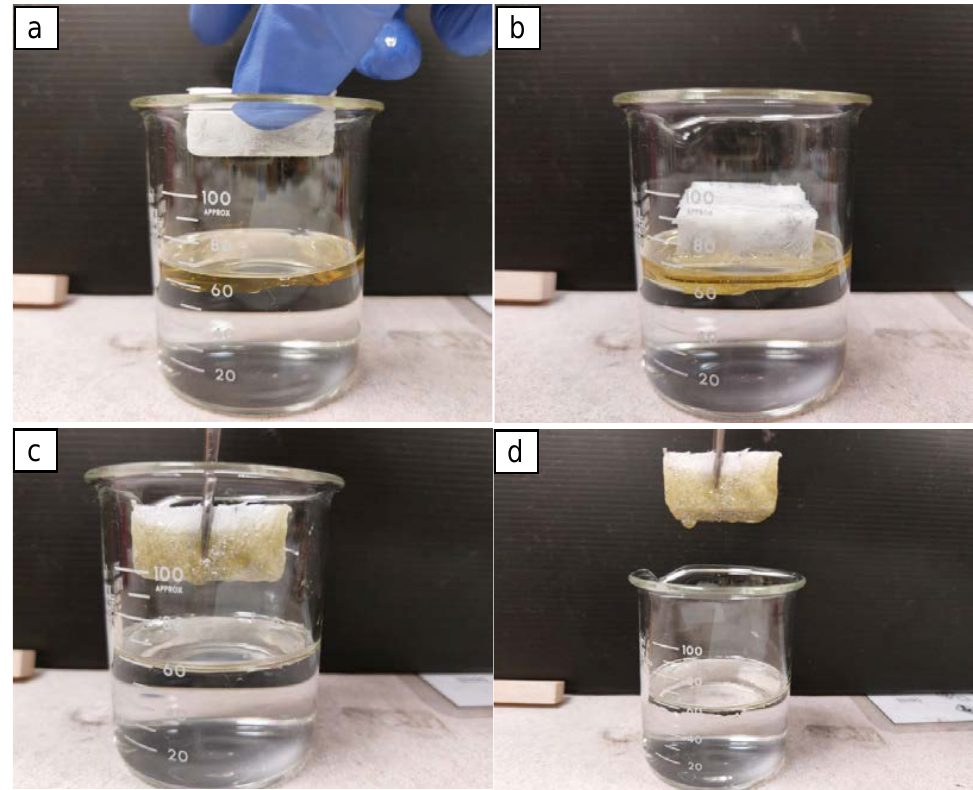
Figure 8. Oil absorption illustrations of A1 extracting commercial oil (Mobil 1 20W - 50 motor oil) from a beaker of water: pre - absorption state of the aerogel ( a ); aerogel absorption of oil begins to take place ( b ); post - absorption state of the aerogel ( c , d ).